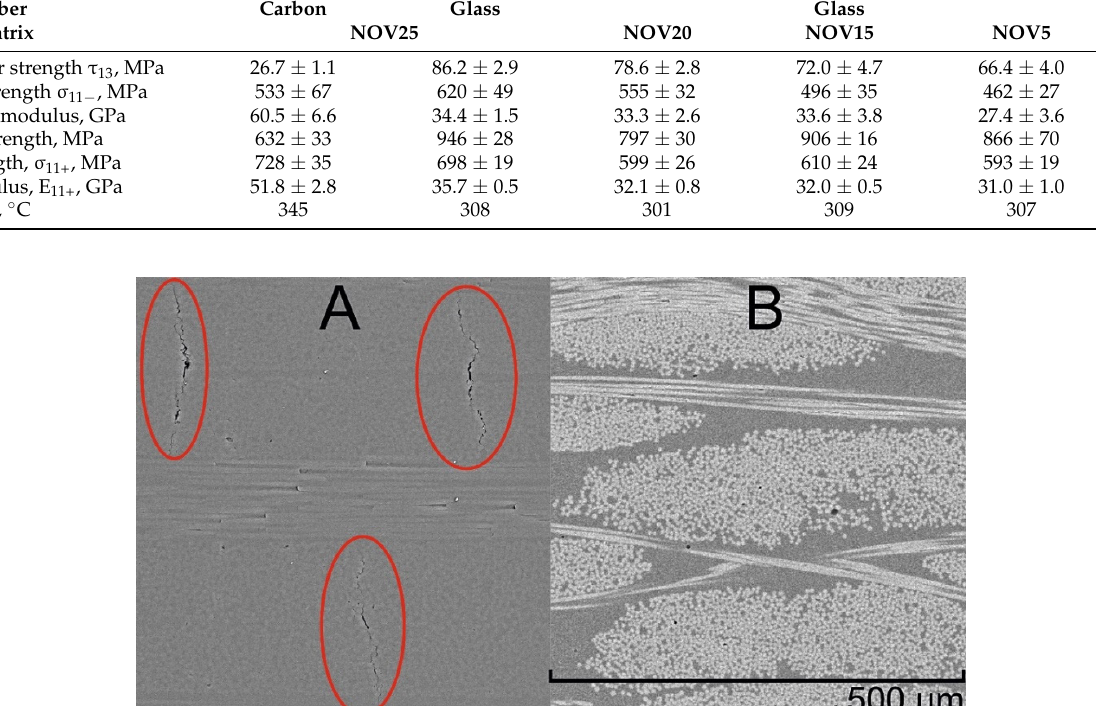
Figure 8. SEM microphotographs of CFRP ( A ), microcracks are circled in red, and GFRP ( B ) with NOV 25 as a matrix.